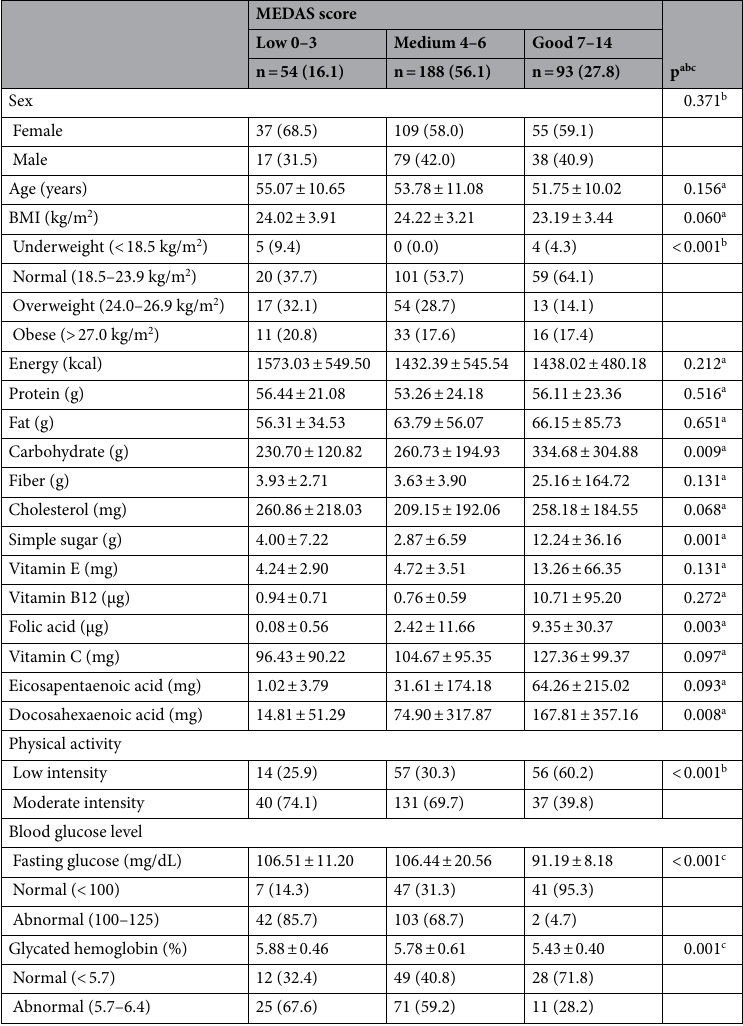
Table 1. Characteristics of participants and blood glucose level by MEDAS score. One-way analysis of a variables (continuous variables) or b Chi-squared tests (categorical variables). c Crude linear regression model. Data are presented as the mean ± standard deviation for continuous variables and n (%) for categorical variables. MEDAS Mediterranean diet adherence screener, BMI Body Mass